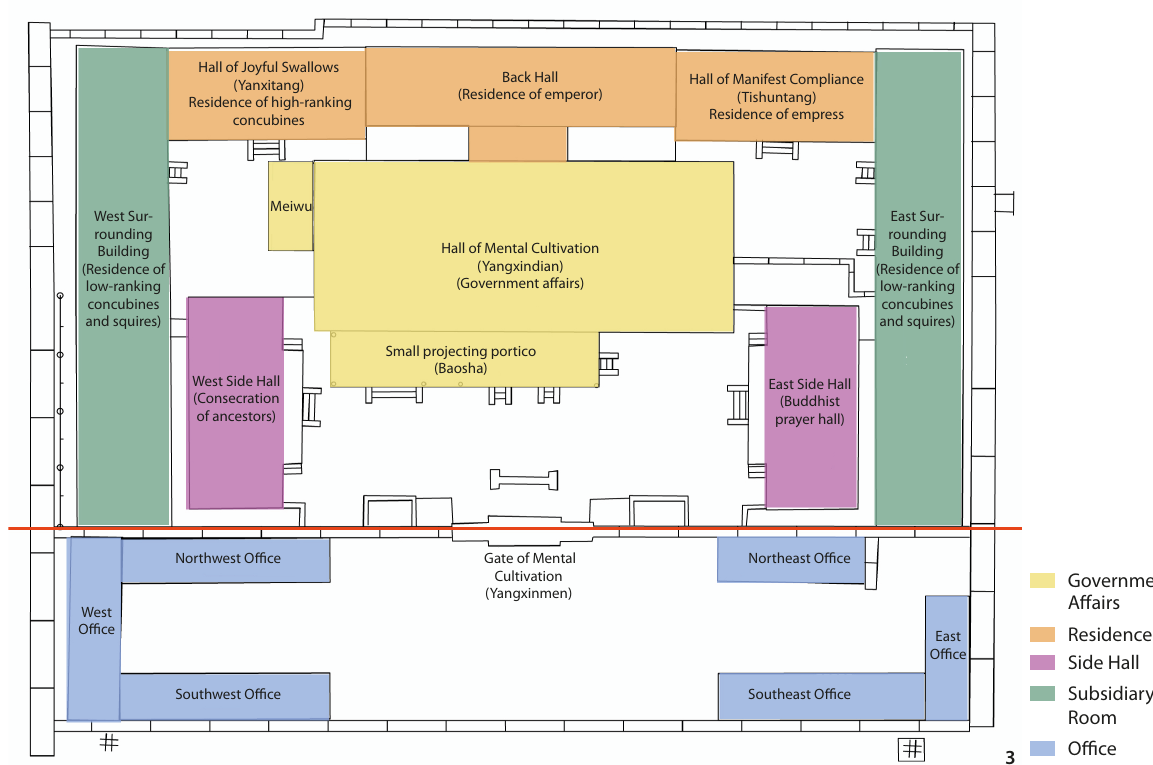
Figure 3 Layout of the functions of the buildings in the Hall of Mental Cultivation Complex in Qing Dynasty (Source: Hong